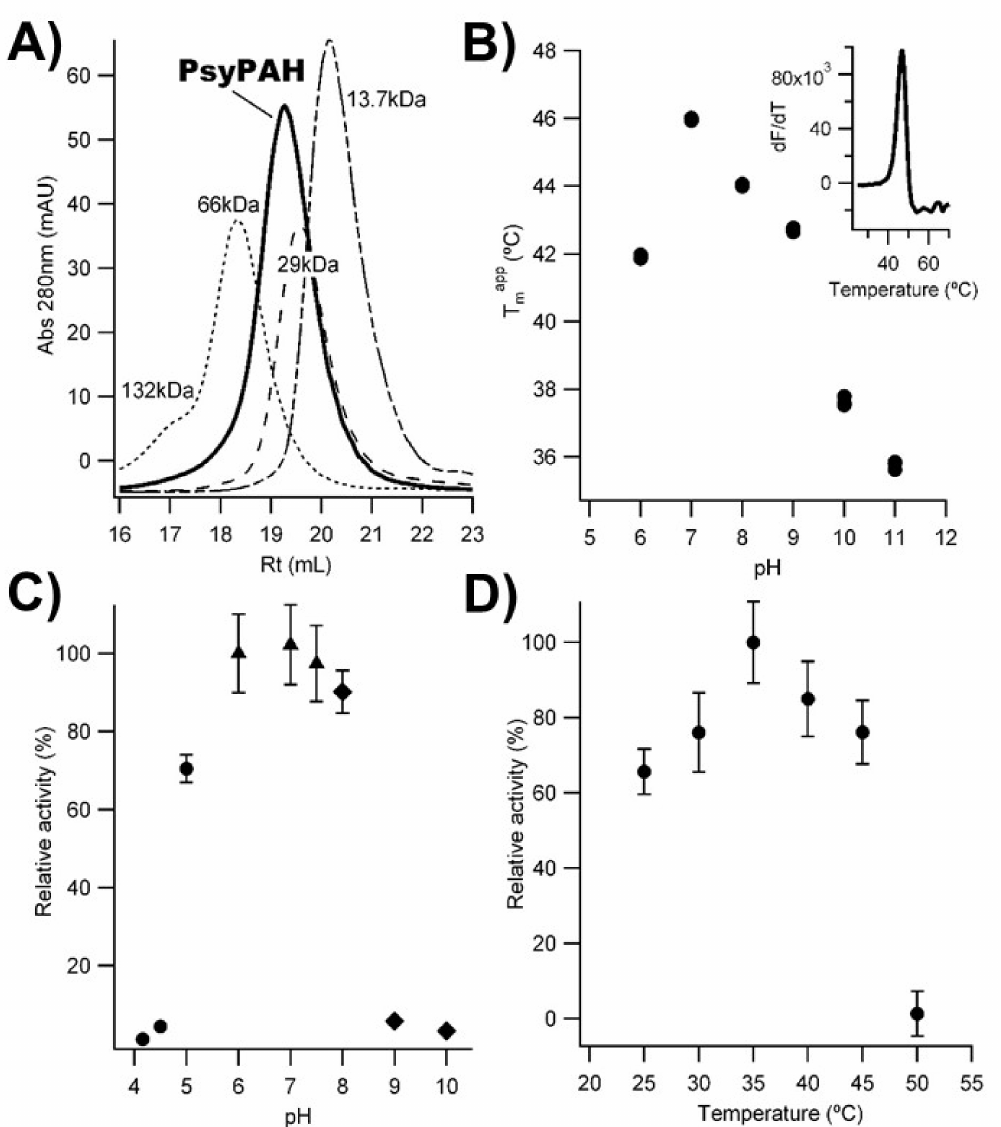
Figure 2. ( A ) SEC-FPLC of PsyPAH (black continuous line) in phosphate buffer 20 mM pH 7.0. Protein standards represented in dashed lines are BSA (132 and 66 kDa), carbonic anhydrase (29 kDa), and RNAse A (13.7 kDa). ( B ) Apparent T m s calculated for PsyPAH at different pHs. The inset corresponds to the TSA experiment of PsyPAH in phosphate buffer at pH 7.0. Relative activity of PsyPAH as a function of pH ( C ) and Temperature ( D